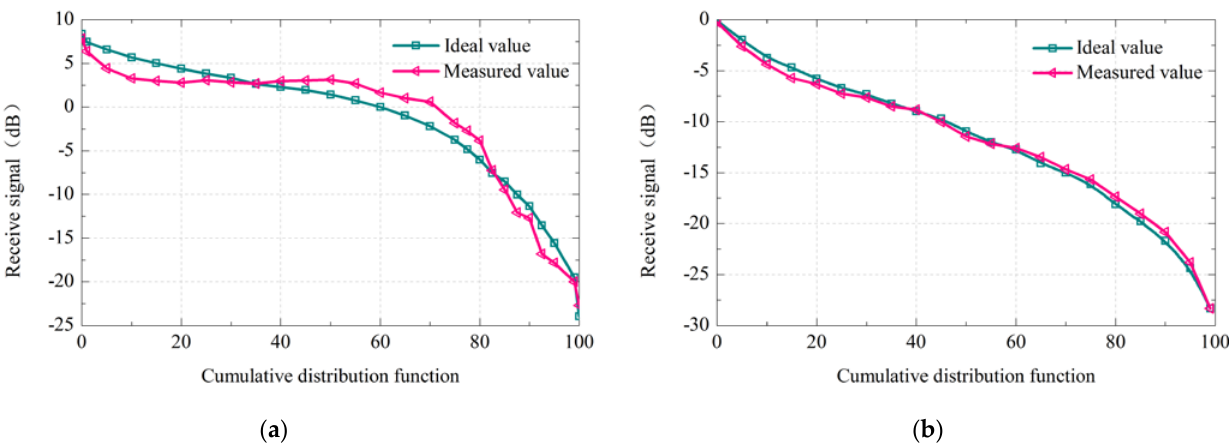
Figure 3. A comparison of measured and calculated values of the signal of Loo model. ( a ) The light shadowing environment; ( b ) The heavy shadowing environment.